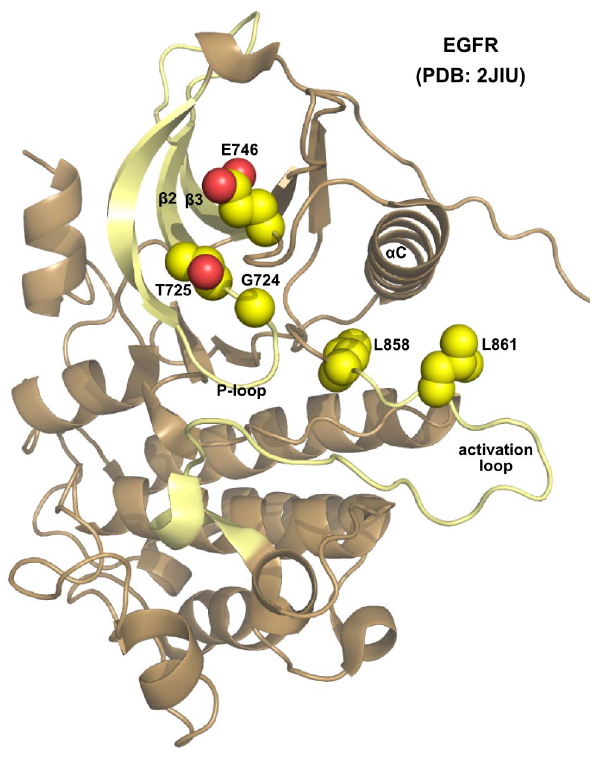
Figure 1. Structural location of selected EGFR mutation sites. Protein crystal structure [PDB:2JIU] shown as cartoon, with sites G724, T725, L858 and L861 shown as spheres. Structural regions highlighted in yellow are kinase subdomain I and the activation loop. The structure image was generated using PyMOL [75].